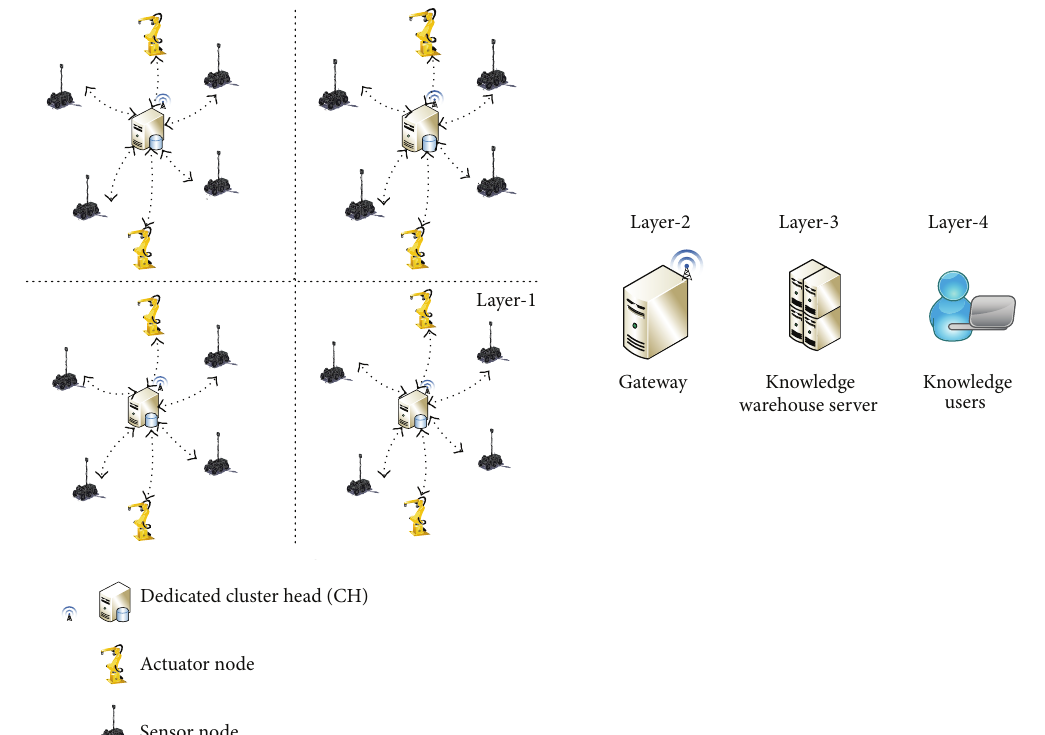
Figure 4: One-hop operational framework for an indoor safety-critical industrial